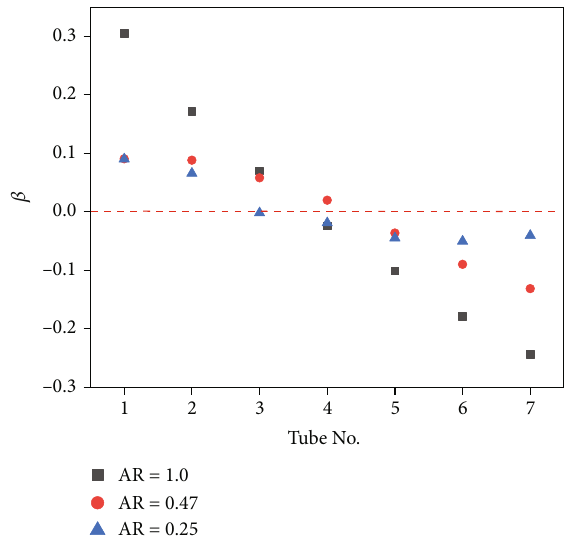
Figure 2: Veri fi cation of numerical methods.